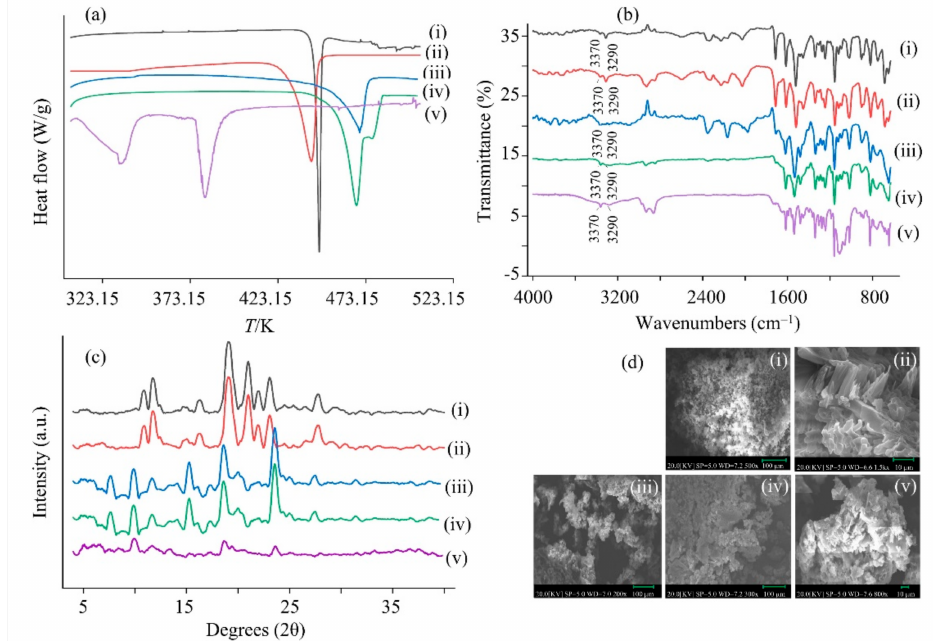
Figure 6. ( a ) DSC thermograms, ( b ) FTIR spectra, and ( c ) PXRD patterns of (i) GLN reference (in black), (ii) GLN-dioxanate (in red), (iii) GLN-NMPate (in blue), (iv) GLN-DMSOte (in green), and (v) GLN-THPate (in violet), respectively, and ( d ) SEM images of (i) GLN reference ( × 500), (ii) GLN- dioxanate ( × 1500), (iii) GLN-NMPate ( × 200), (iv) GLN-DMSOte ( × 300), and (v) GLN-THPate ( ×